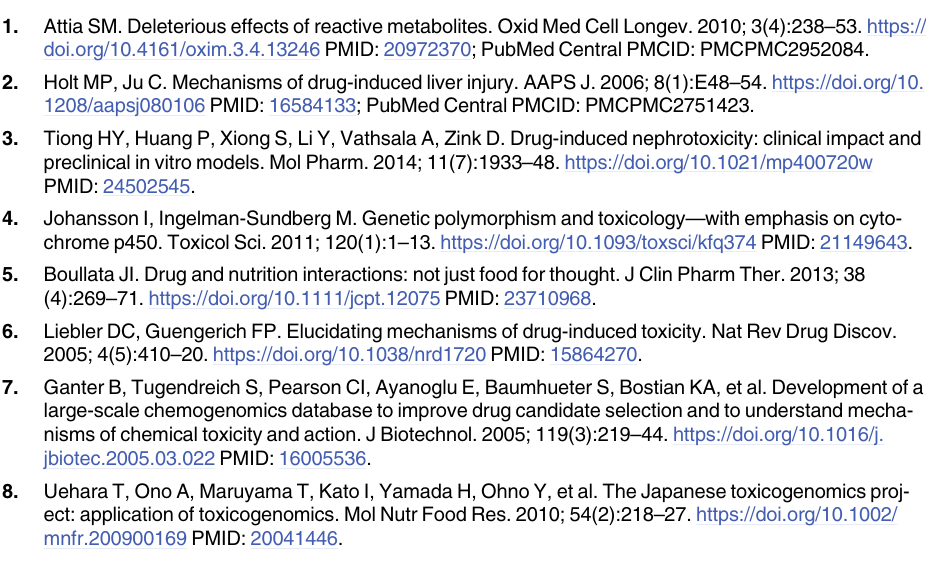
S13 File. Functional enrichment analysis for genes dys-regulated in rat hepatocytes but not in rat liver. Text file with the output of a functional term enrichment analysis using the g:Pro- filer web tool for the top-100 ranked genes according to the difference between the RH and the RL